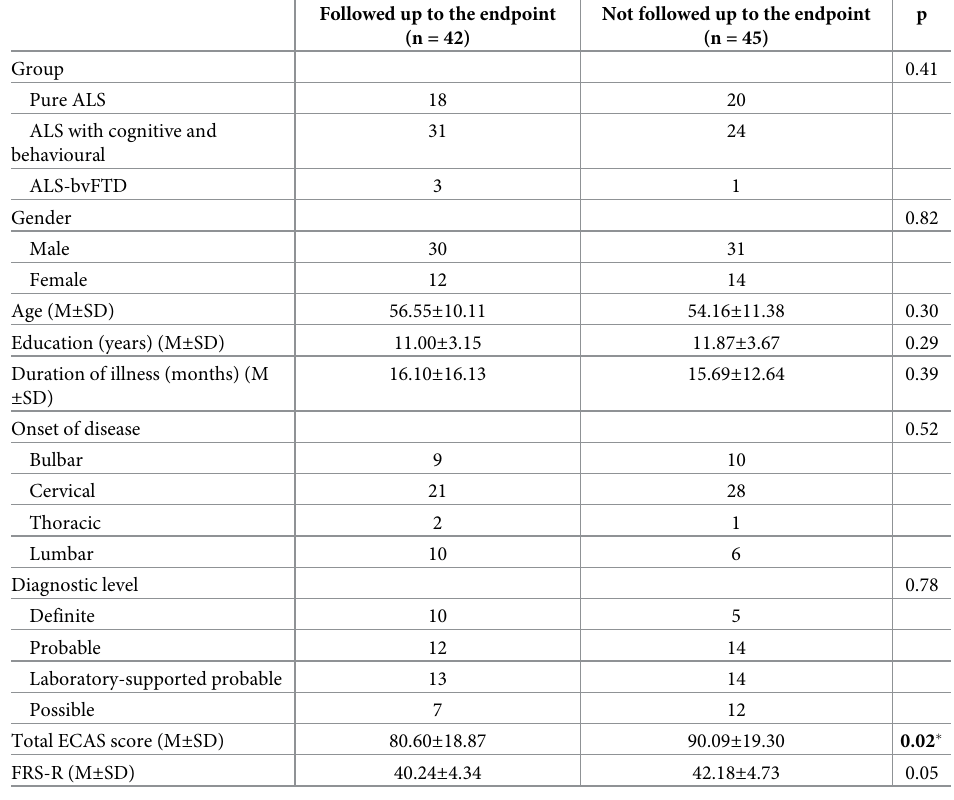
Table 2. Comparison between followed up to the endpoint and not to the endpoint groups.